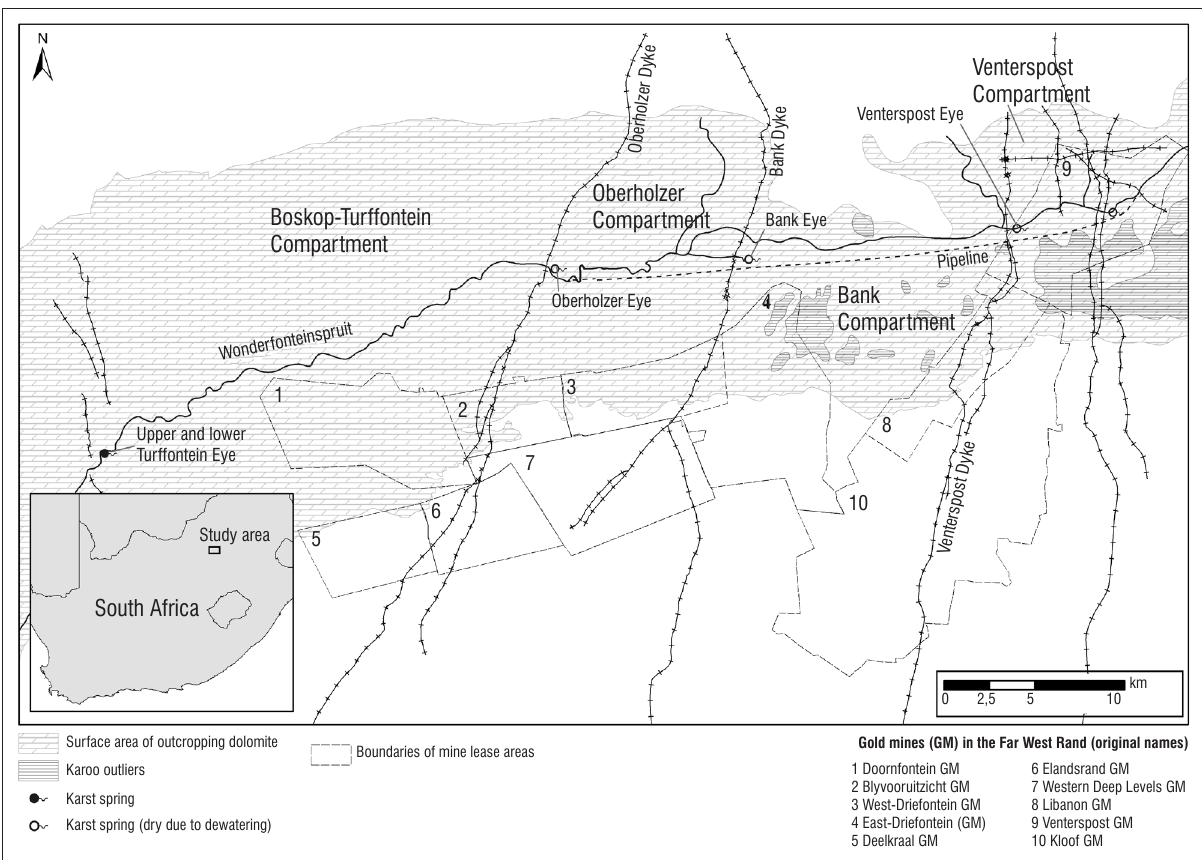
Figure 1: Locality plan and map of the central part of the Far West Rand goldfield showing the surface area of outcropping water-bearing dolomite, the position of dykes and the boundaries of mine lease areas.